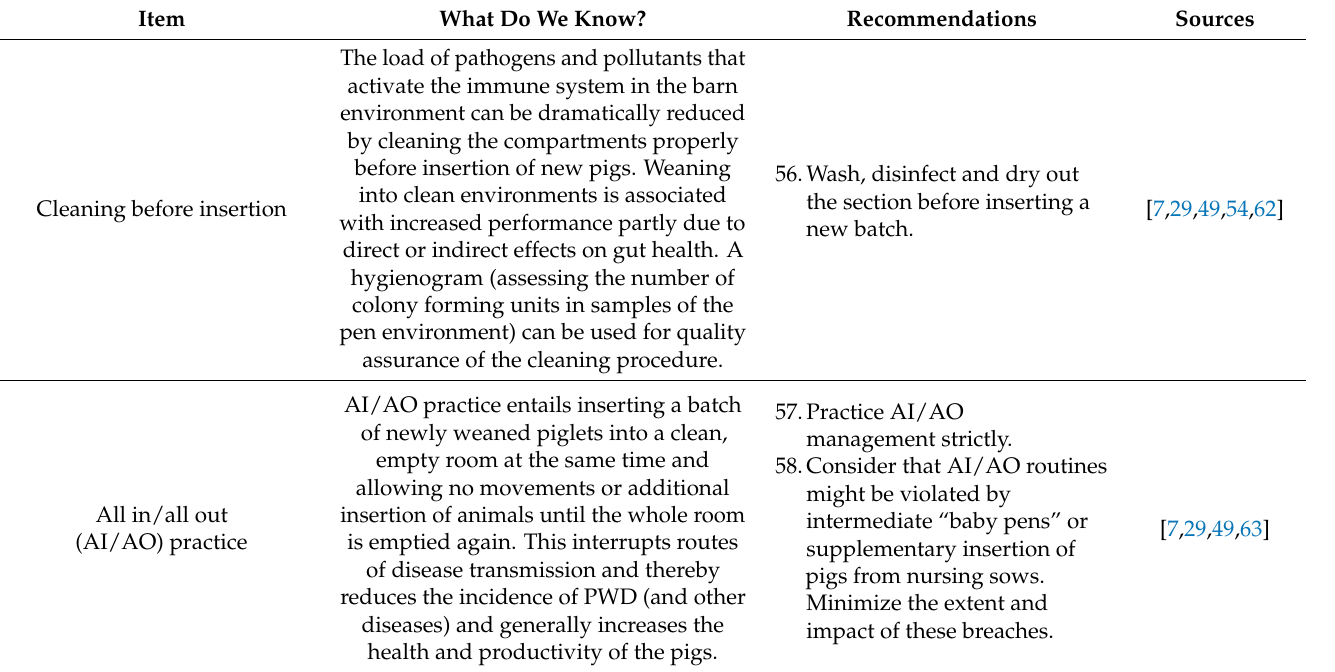
Table 6. Biosecurity and